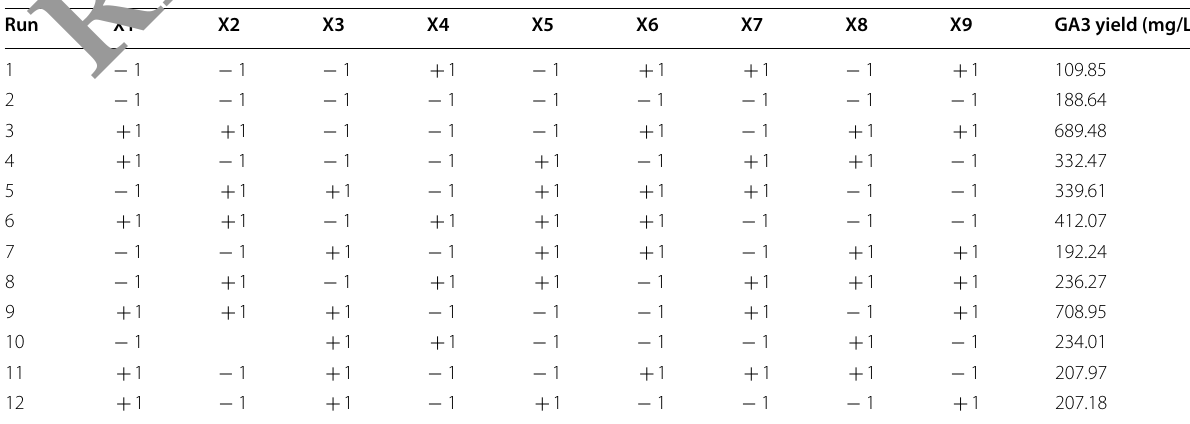
Table 3 Matrix of Plackett–Burman design and results of the response (GA3 yield) Run